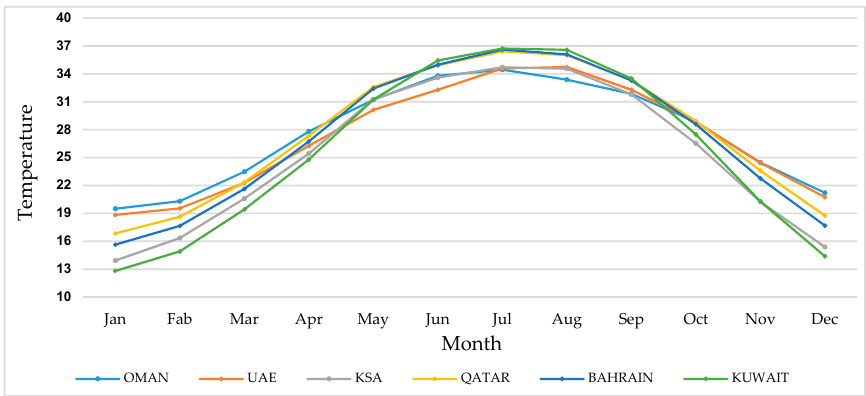
Figure 5. Average monthly temperature for the Gulf Cooperation Council (GCC) from 1901 to 2015 (source: worldbank.org).